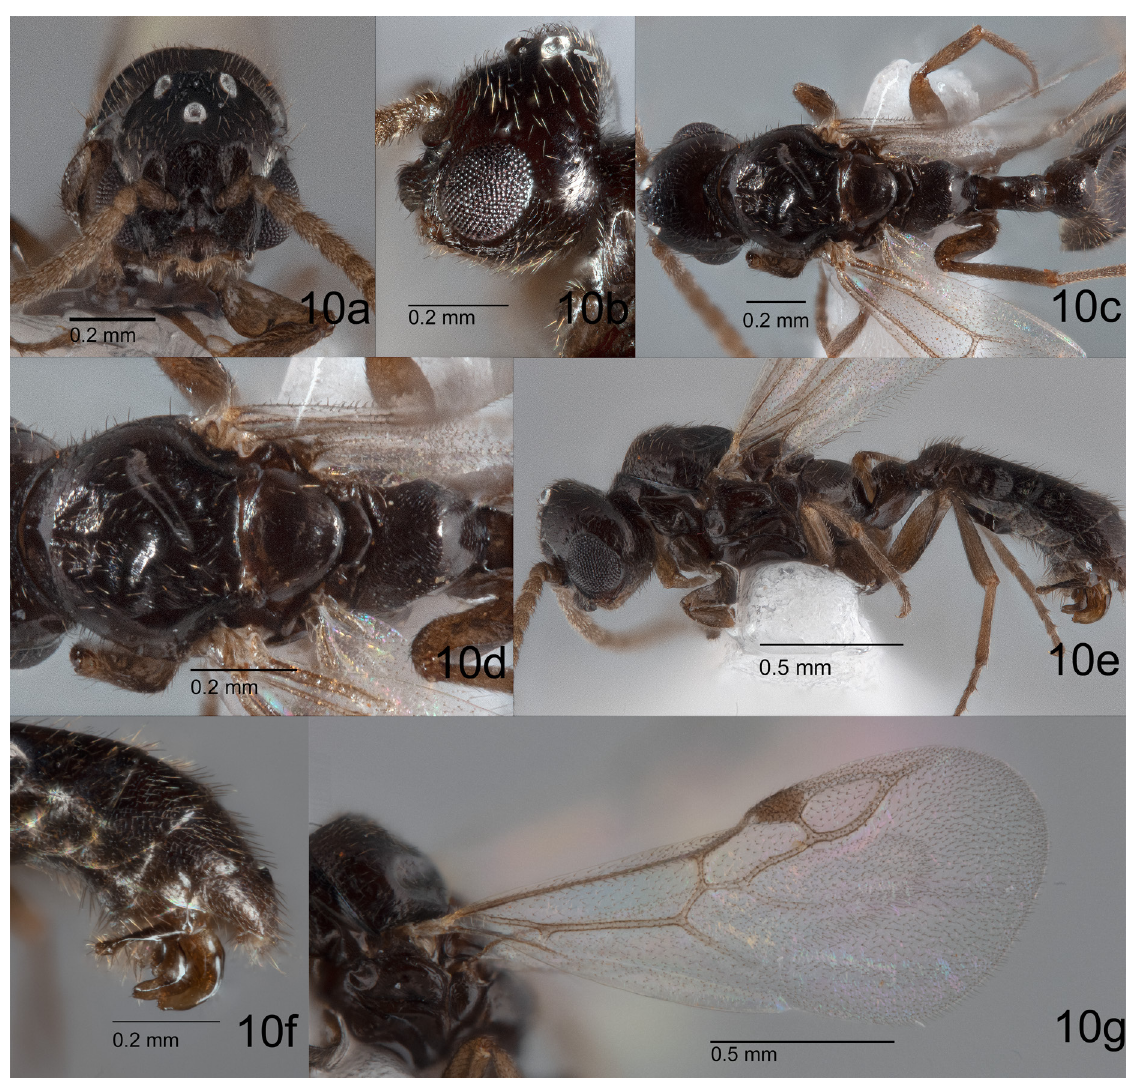
Fig. 10. Rhopalomastix johorensis Wheeler, 1929, non-type, ♂, Central Thailand (ZRC_ENT00013956). a . Head in full-face view. b . Head in profile. c . Body in dorsal view. d . Close-up of mesosoma in dorsal view. e . Body in lateral view. f . Close-up of genitalia in profile. g . Forewing in lateral